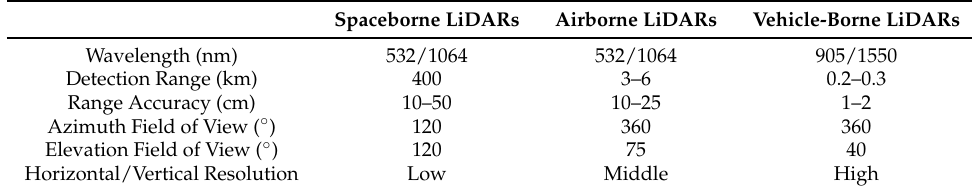
Table 2. Comparison of LiDARs on different platforms.